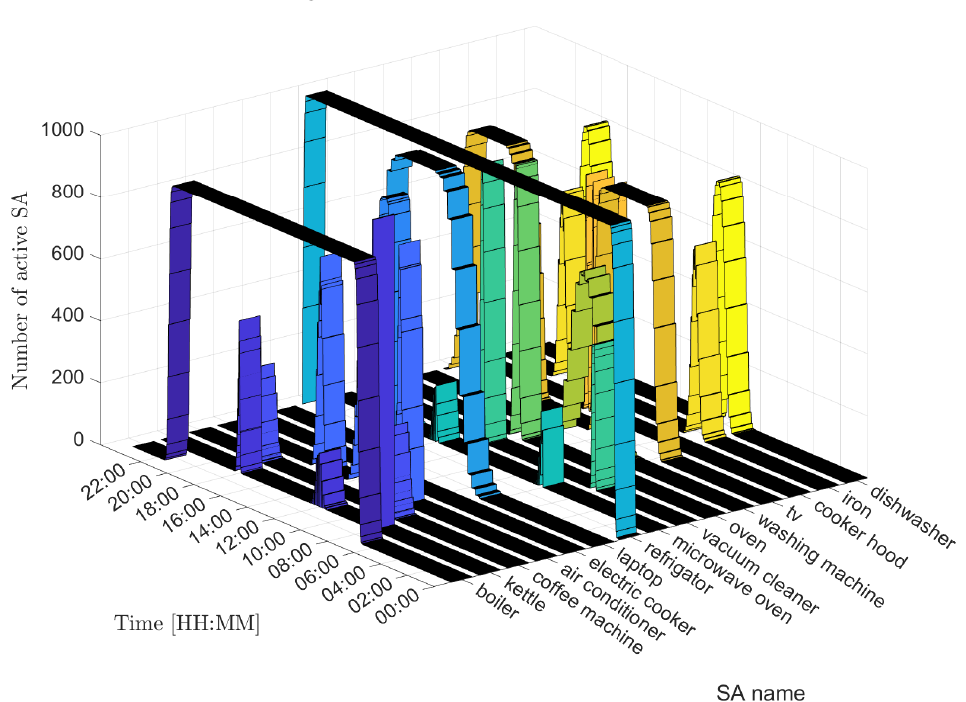
Figure 11. SA usage